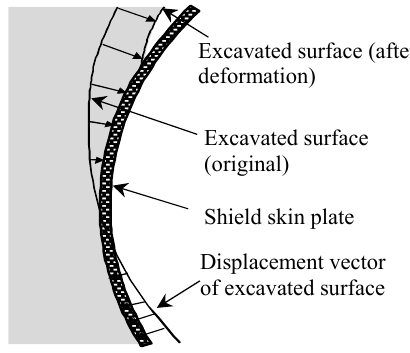
Figure 4. Displacement of the excavated surface.